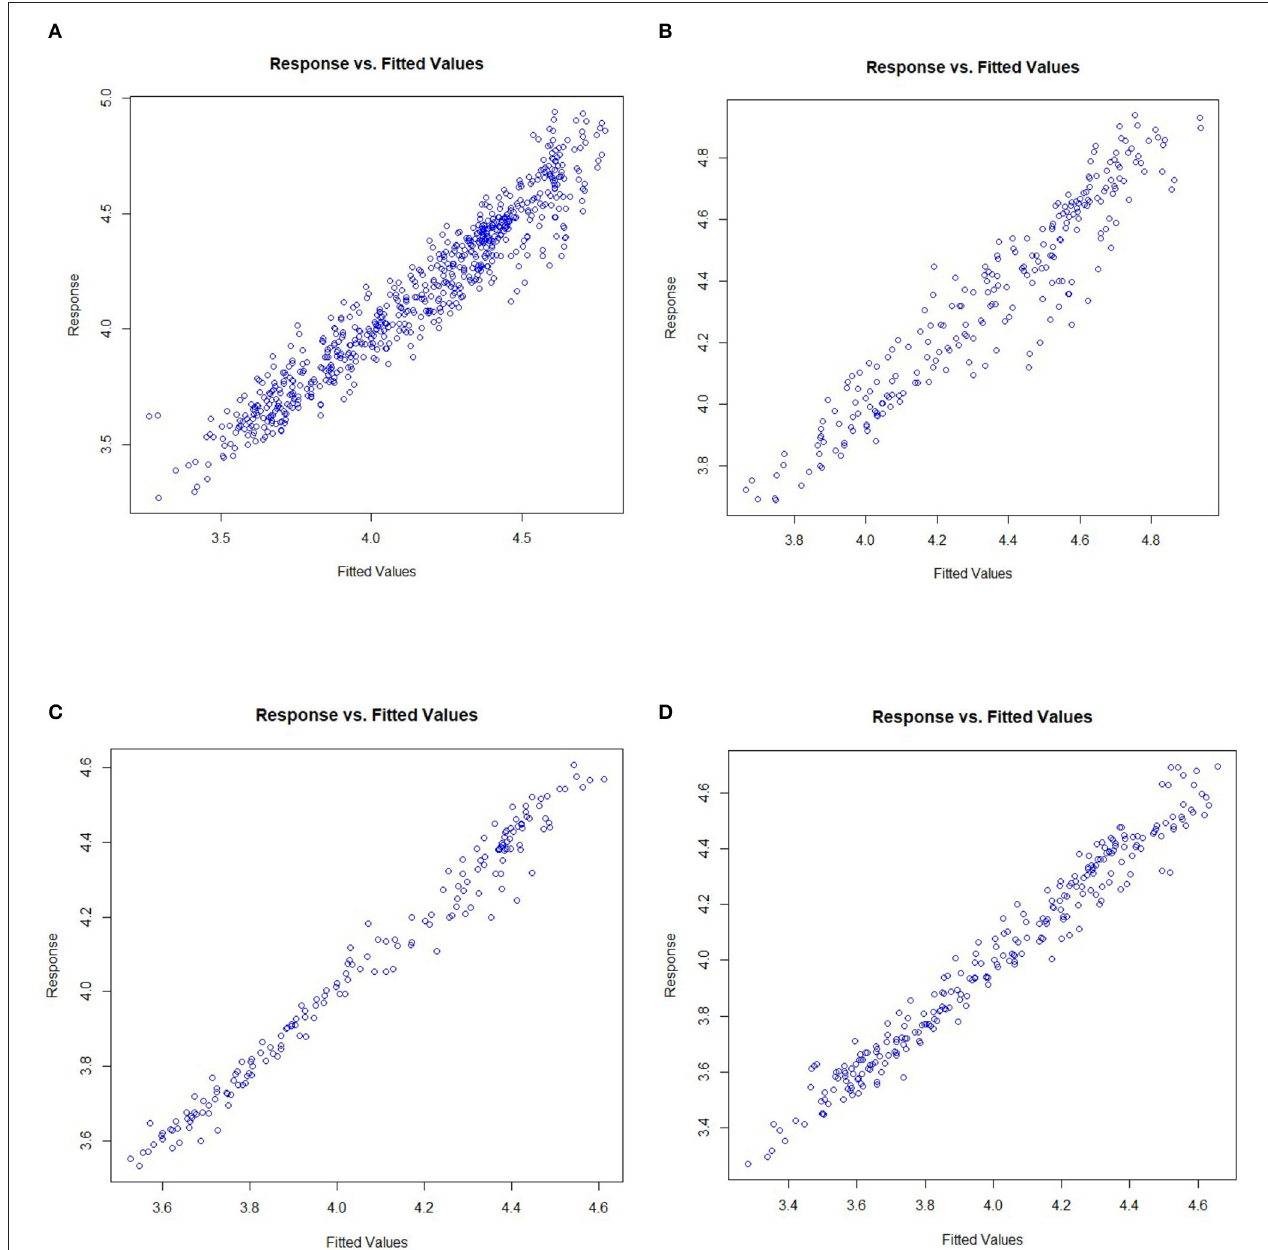
FIGURE 11 | Plots of the response values vs. the fitted values for the nation and the eastern, central, and western regions. (A) Nation, (B) Eastern region, (C) Central region, and (D) Western